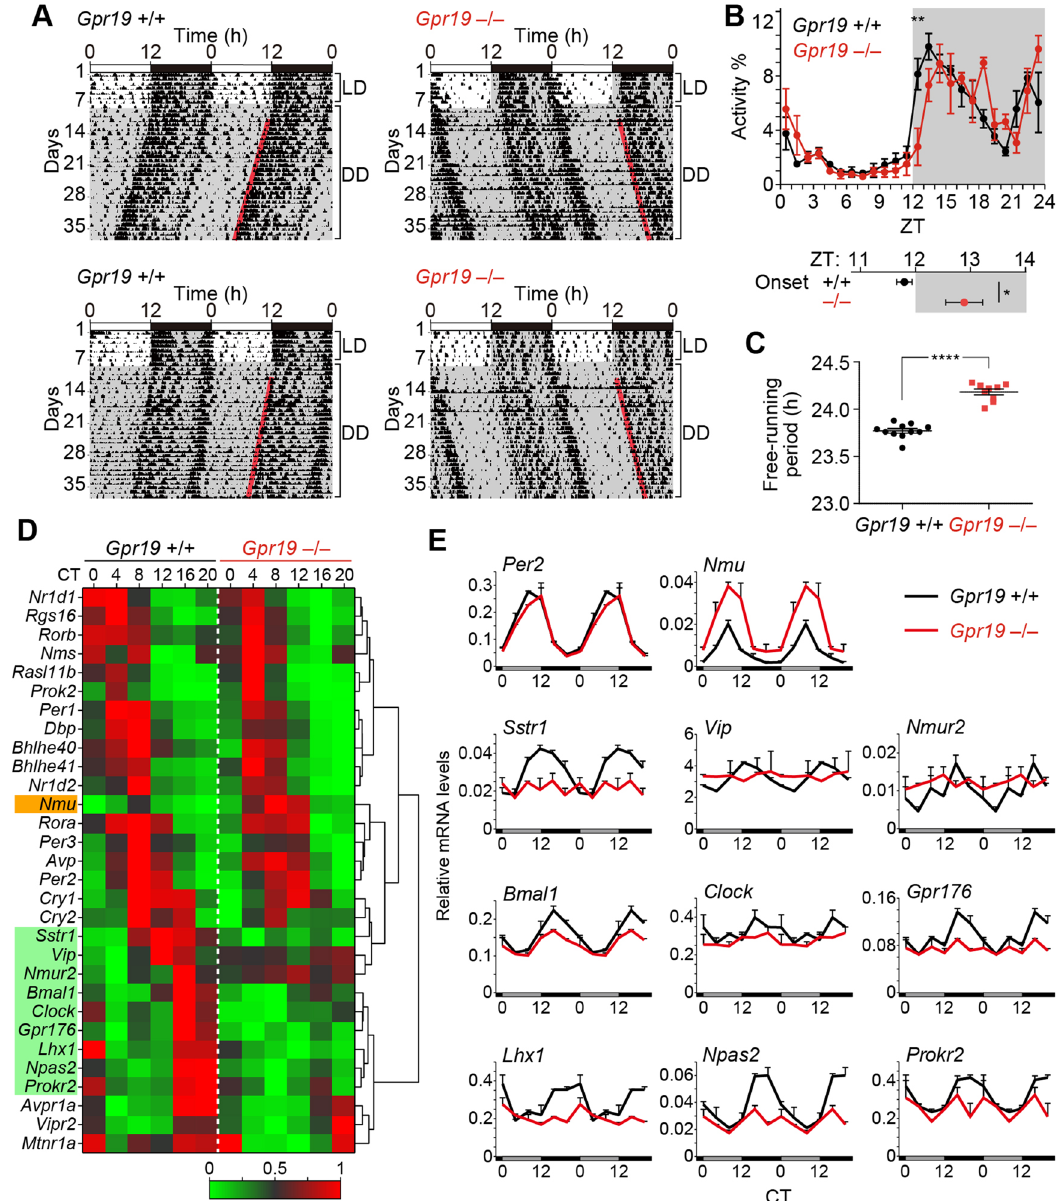
Figure 3. Gpr19 deficiency elongates the period of locomotor activity rhythm and alters circadian clock gene expression in the SCN. ( A ) Representative double-plotted locomotor activity records of C57BL/6J-backcrossed Gpr19 +/+ and Gpr19 −/− mice. Mice were housed in a 12L:12D light–dark cycle and transferred to DD. Periods of darkness are indicated by grey backgrounds. Each horizontal line represents 48 h; the second 24-h period is plotted to the right and below the first. The coloured lines delineate the phase of activity onset in DD. ( B ) Daily profile of locomotor activity of Gpr19 +/+ and Gpr19 −/− mice in LD. Values are the mean ± SEM of % activity of a day. ** P < 0.01, two-way ANOVA with Bonferroni’s post hoc test. The plots below the panel indicate the average times of locomotor activity onset of Gpr19 +/+ and Gpr19 −/− mice. * P < 0.05, Student’s unpaired t -test. ( C ) Period-length distribution of C57BL/6J-backcrossed Gpr19 +/+ and Gpr19 −/− mice. Free-running period measurements were based on a 14-day interval taken after 3 days of a DD regime and were executed with a χ 2 periodogram. Plotted are the period lengths of individual animals. Bars indicate the mean ± SEM ( Gpr19 +/+ , n = 11; Gpr19 −/− , n = 9). **** P < 0.0001, Student’s unpaired t -test. ( D ) Heatmaps displaying circadian expression of representative clock and clock-related genes in the SCN of Gpr19 +/+ and Gpr19 −/− mice. The highest and lowest values of each gene were adjusted to 1 and 0, respectively. The genes (rows) are ordered by hierarchical clustering using Euclidean distance and Ward agglomeration. ( E ) Line graphs showing double-plotted circadian expression profiles of the genes affected by Gpr19 deficiency in ( D ). Relative mRNA levels were determined by qRT-PCR ( n = 2 biological replicates, for each data point). Error bars indicate variation. Values are double- plotted for better comparison between the genotypes. Per2 is not affected. Data of all examined genes are shown in Supplementary Fig.